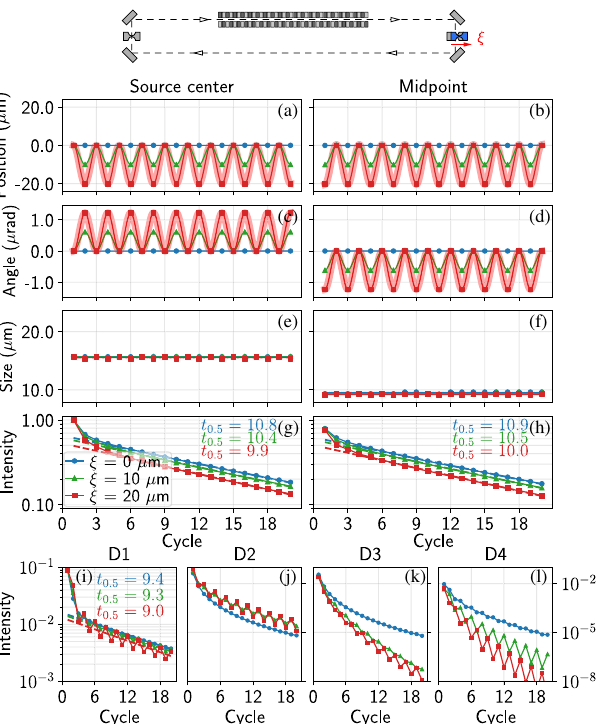
FIG. 24. Similar to Fig. 21, but with position error ξ at crystal C 4